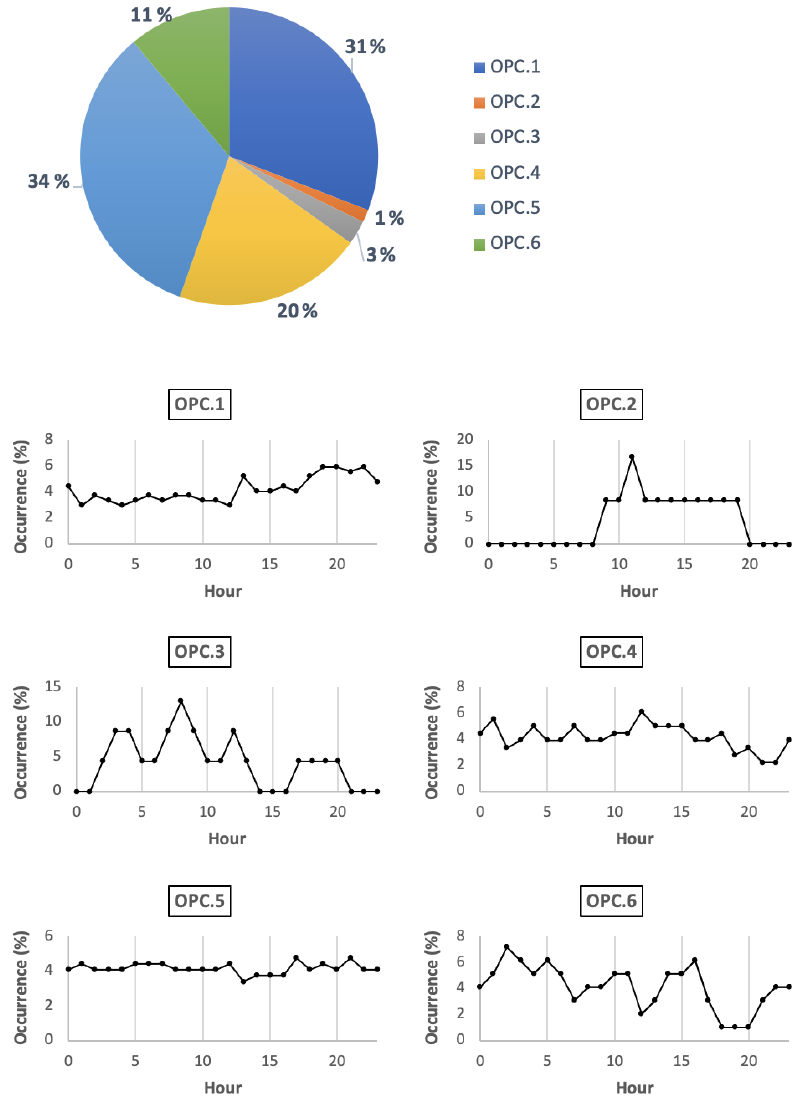
Figure 2. Frequency and diurnal variation of the clusters formed by the OPC